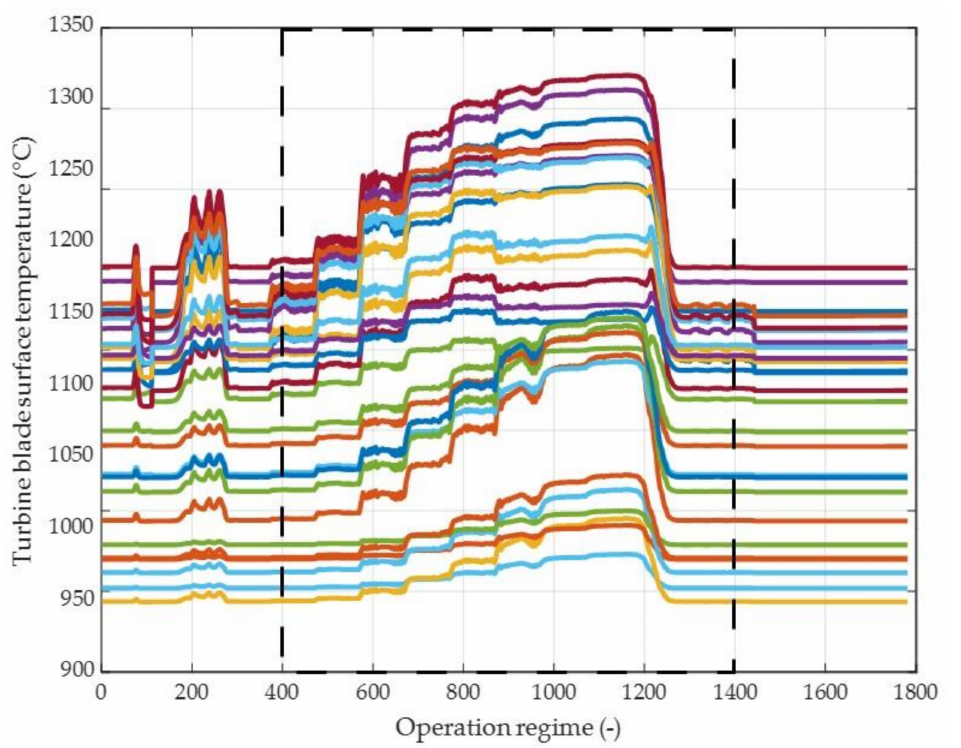
Figure 10. Estimated temperatures for one whole engine run using the new methodology based on the